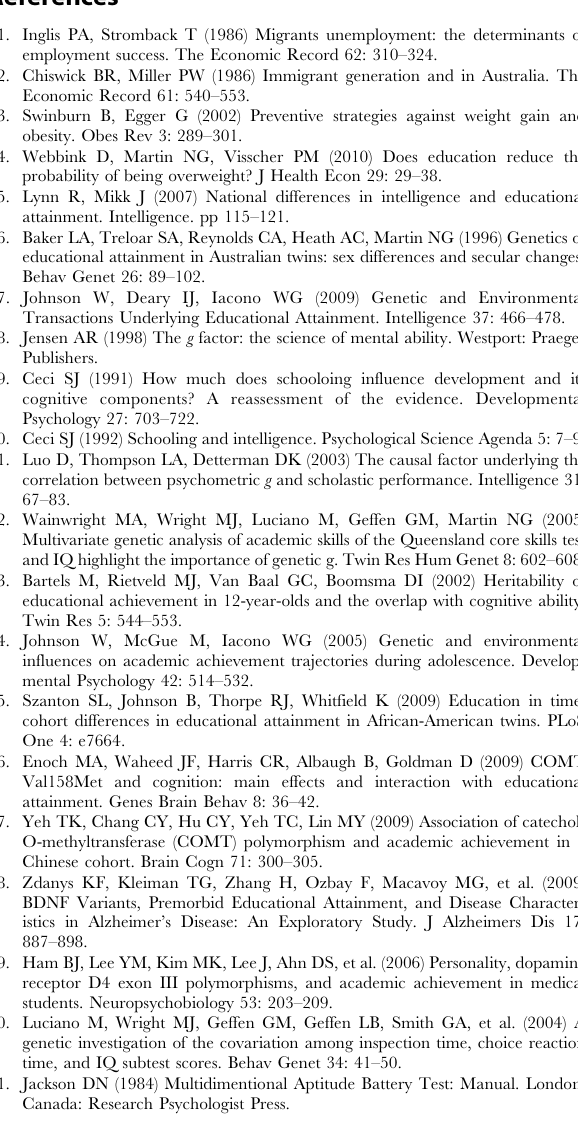
Figure S1 Quantile-Quantile plot from the GWAS result of educational attainment in 9538 individuals. (Lambda = 1.0229). The grey shade area represents the 95% confidence intervals. Figure S2 Manhattan plot of GWAS for educational attainment for 9538 individuals. X-axis represents the chromosomal loca-